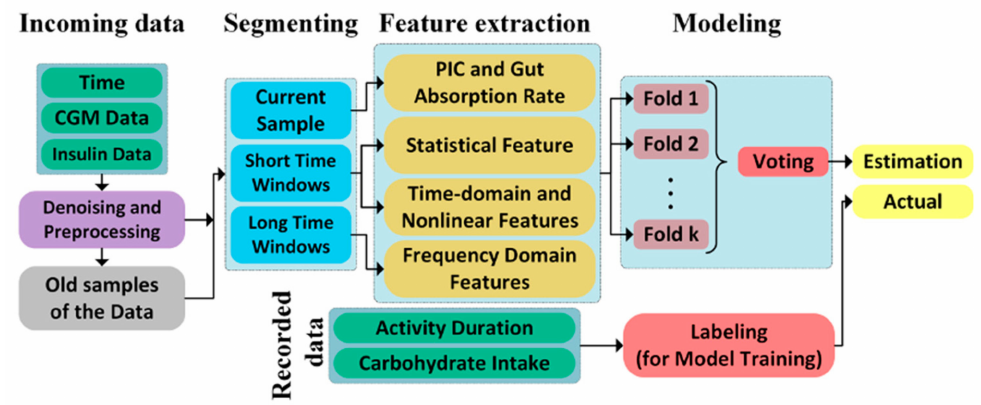
Figure 5. The diagram of workflow for data processing, feature extraction, and modeling [18].